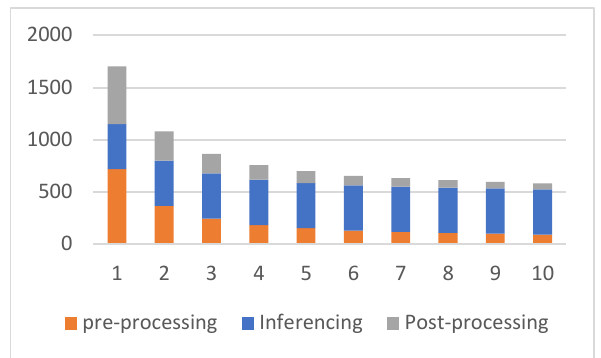
Figure 14. Comparison of time taken for multiple GPUs to process 1600-million-pixel images in a single HPC